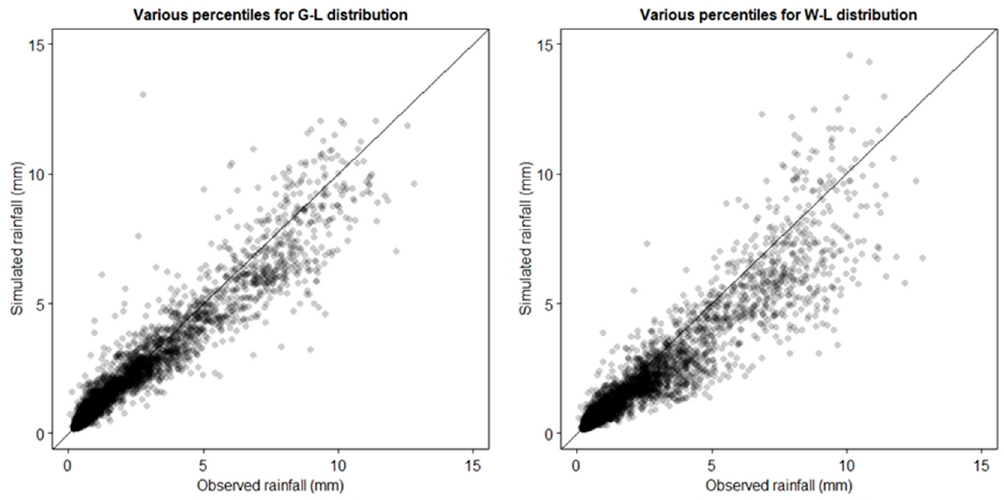
Figure 5. The scatter plot presenting various percentiles of observed and simulated (with interpolated parameters) sub-daily rainfall.